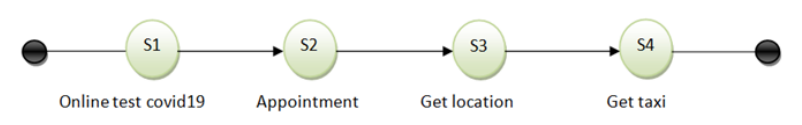
Figure 7. A prototype application for online test